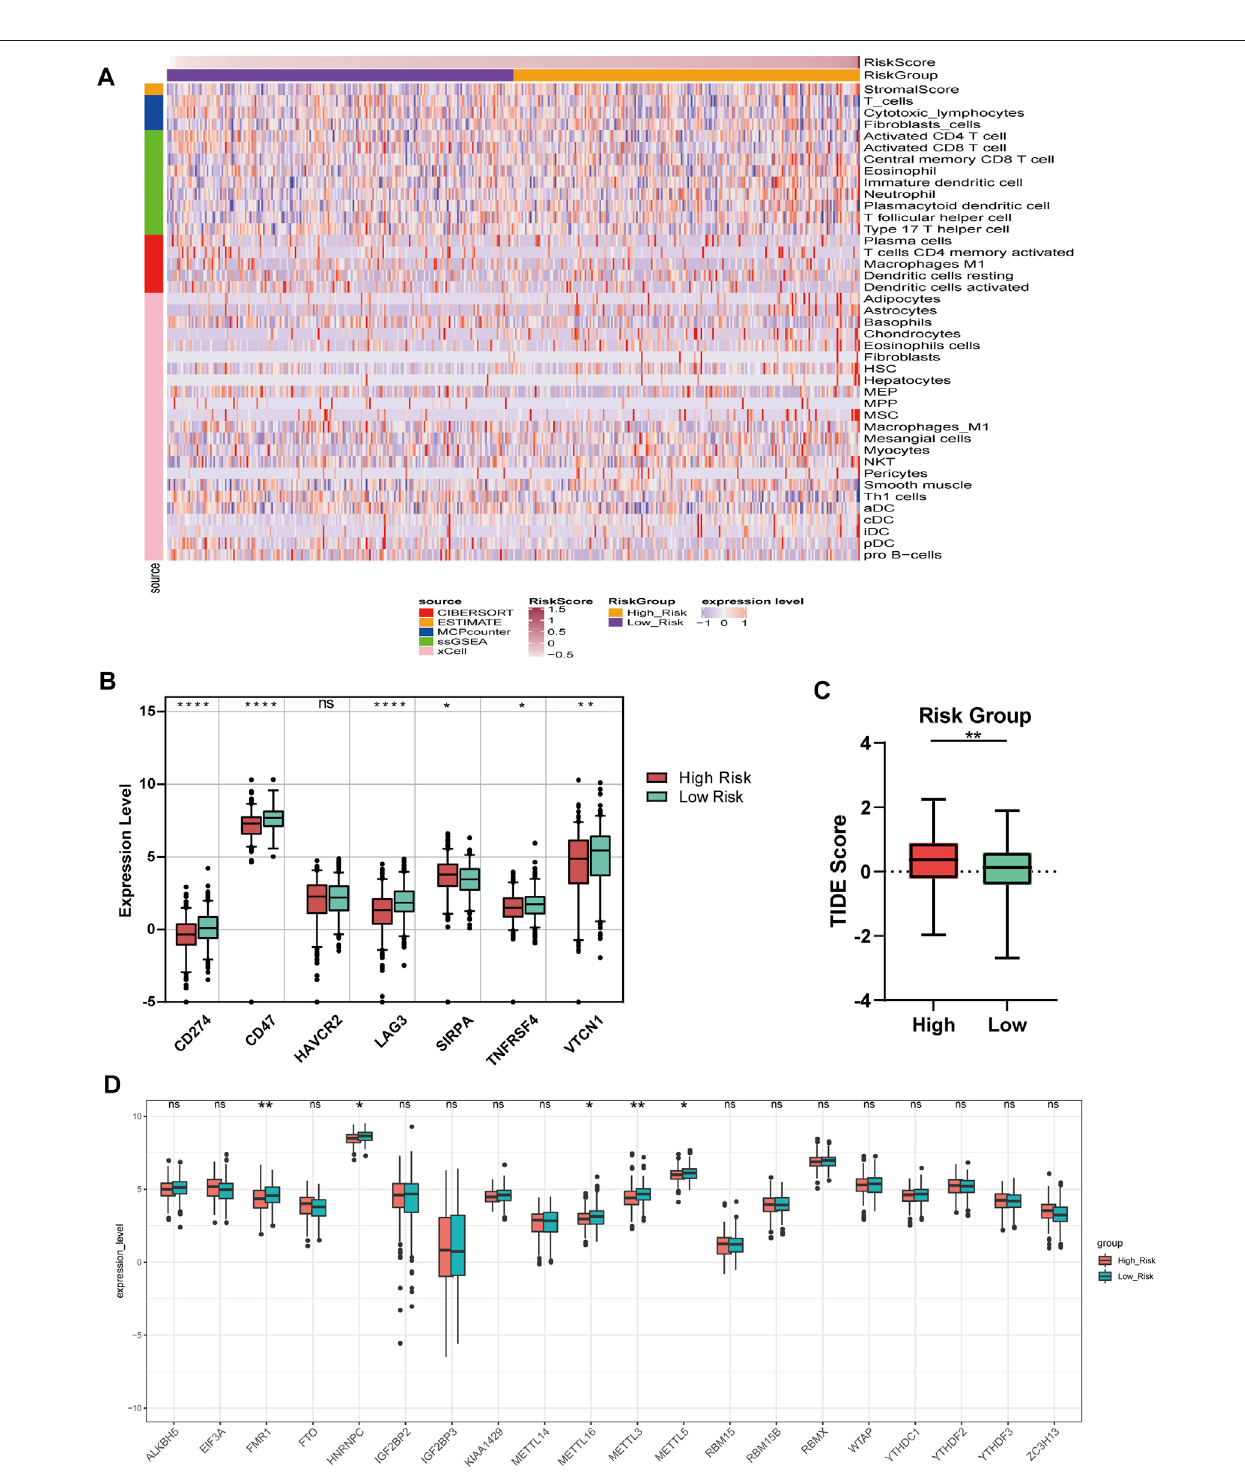
FIGURE 7 | Immune and m6A analysis (A) Heatmap of immune microenvironment revealed that a total of 40 immune cells and stromal score had signi fi cant differences between the two risk groups (B) Expression of seven immune checkpoint genes between high and low-risk group. The other six genes had signi fi cant differences between the two groups ( p < 0.05), except HAVCR2 ( p (cid:2) 0.66) (C) TIDE scores in the low-risk group were lower than those in the high-risk group (D) The expression of 20 m6A regulators between high and low-risk groups. Data are shown as means ± S.D. ns: not signi fi cant, * p < 0.05, ** p < 0.01, *** p < 0.001, **** p <